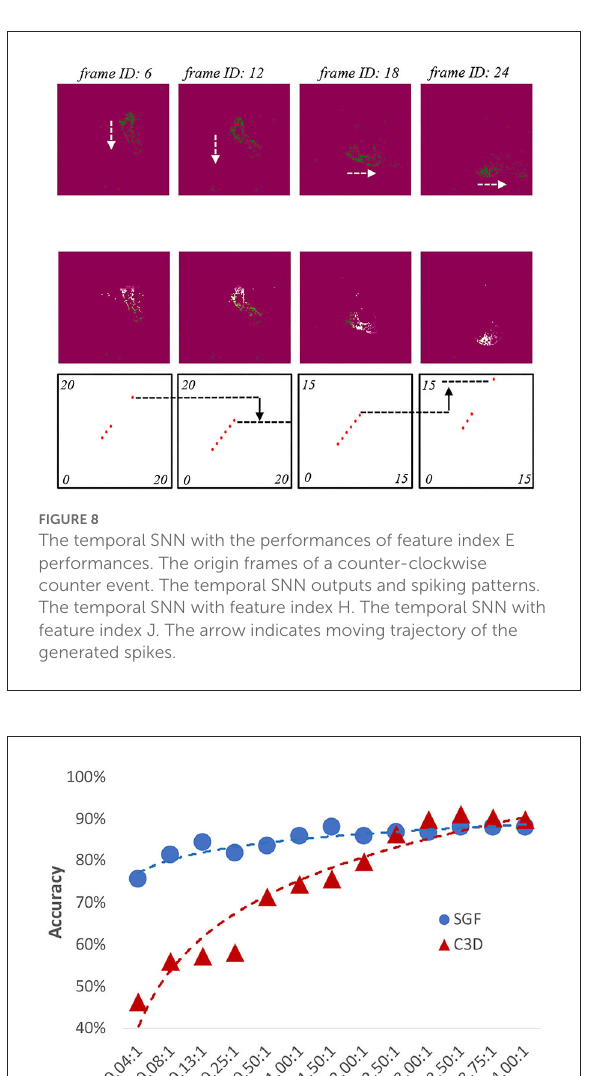
FIGURE9 A comparison of the few-shot learning (FSL) performances on both SGF and C3D networks.